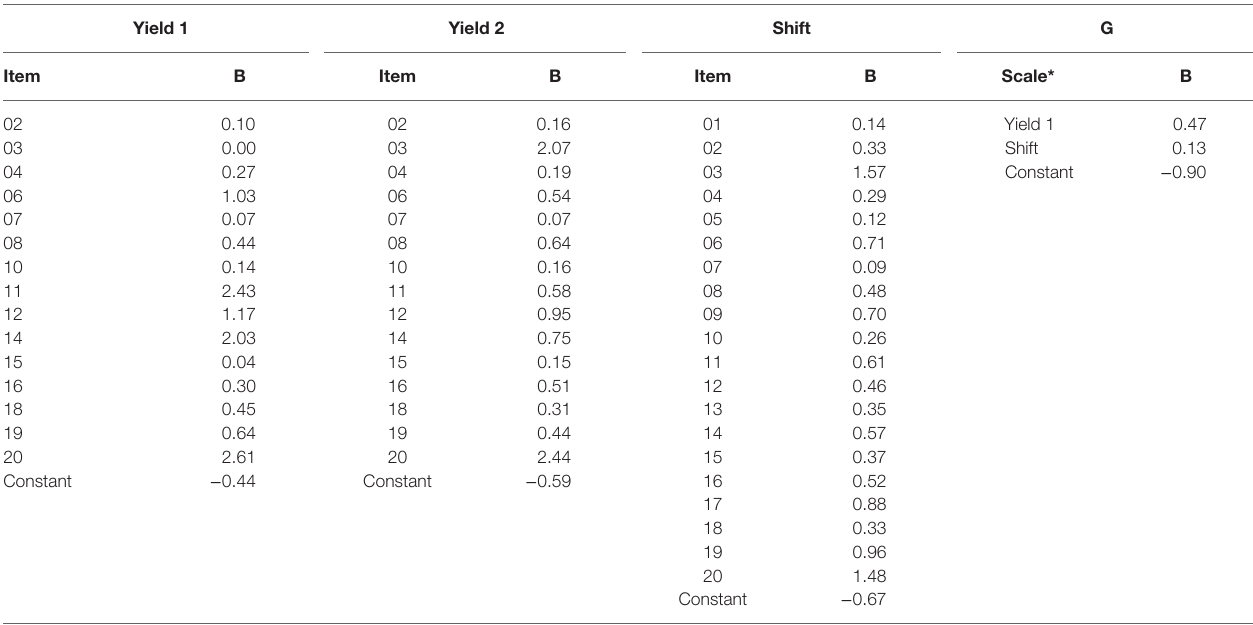
TABLE 6 | B-weights (regression coefficients) and constant for the computation of factor scores. Yield 1 Yield 2 Shift G Item B Item B